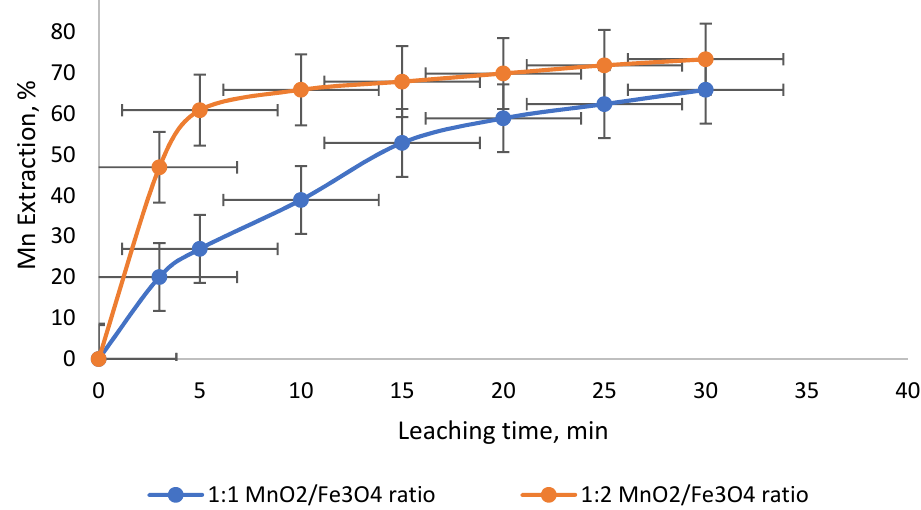
Figure 1. Manganese dissolution from marine nodule at different ratios of MnO 2 /Fe 3 O 4 and 0.1 mol/L H 2 SO 4 .